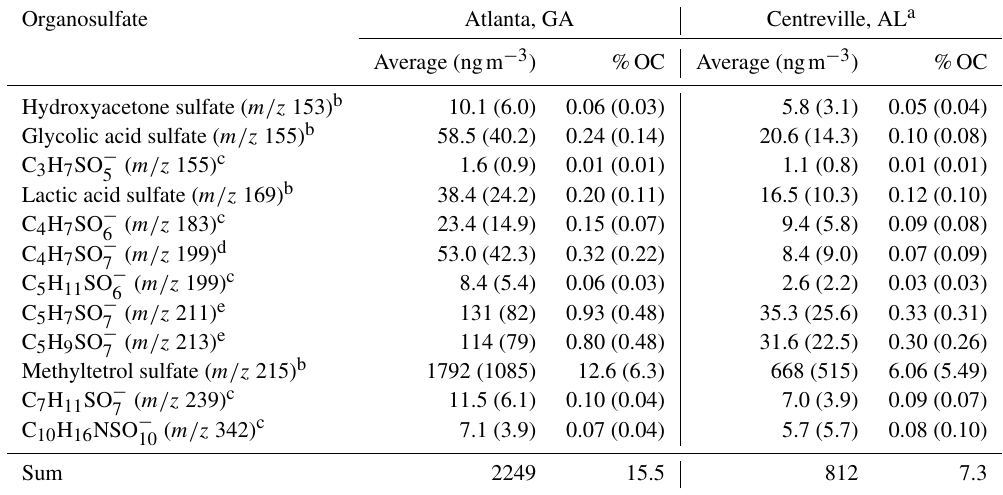
Table 2. Comparison of organosulfates quantified or semi-quantified in Centreville, AL, from 13 June to 13 July 2013 and in Atlanta, GA, in August 2015. Standard deviations are given in